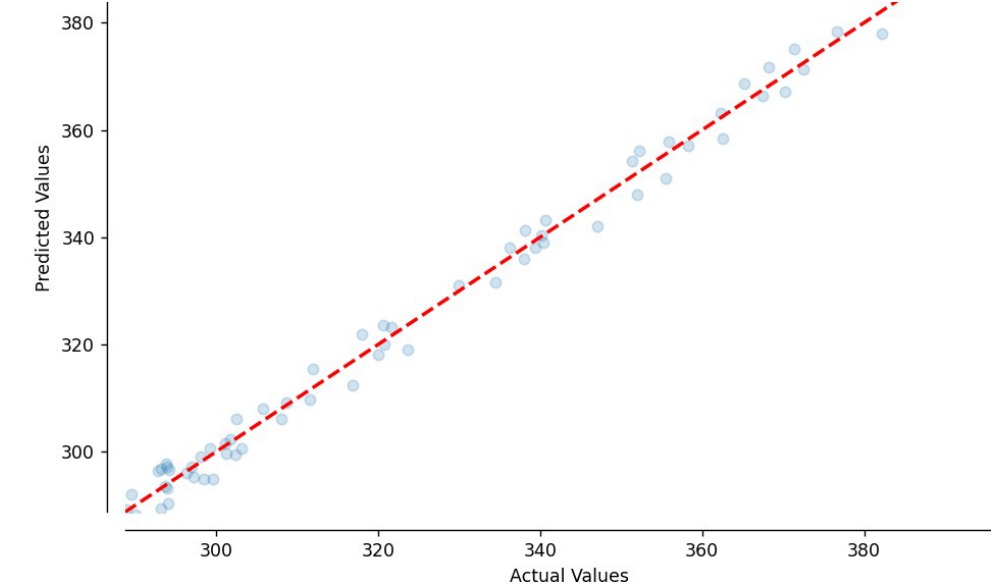
Figure 1. A sample of the distribution of predicted and actual values around the